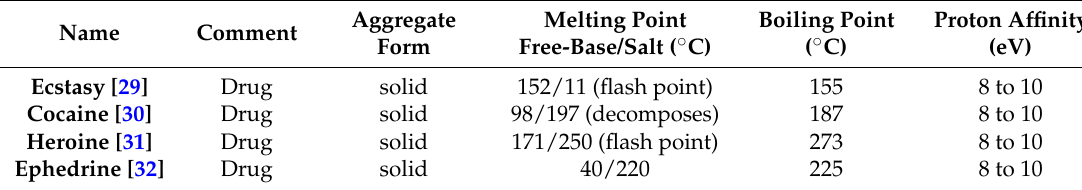
Figure 3. ( a ) Free-base form of cocaine; ( b ) salt-like cocaine hydrochloride. Table 3. Molecular properties of illicit drugs; ephedrine is an easily available drug surrogate.